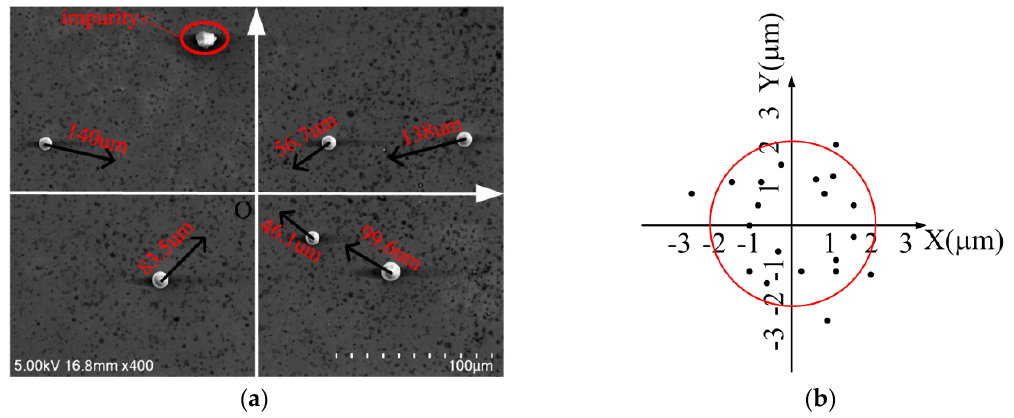
Figure 9. ( a ) The microparticles are to move to location O . ( b ) Final locations of microparticles around the